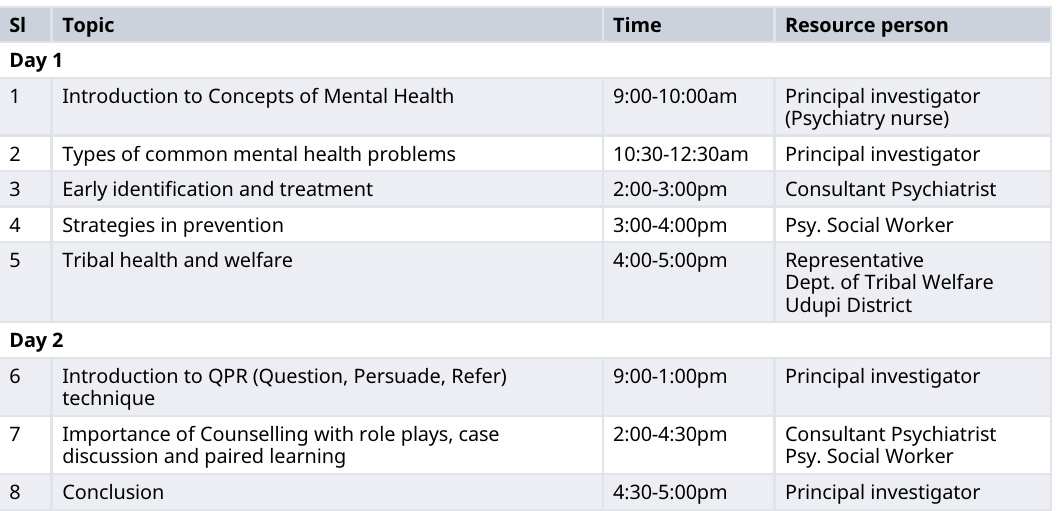
Table 1. Outline of the two-day workshop on GTP.